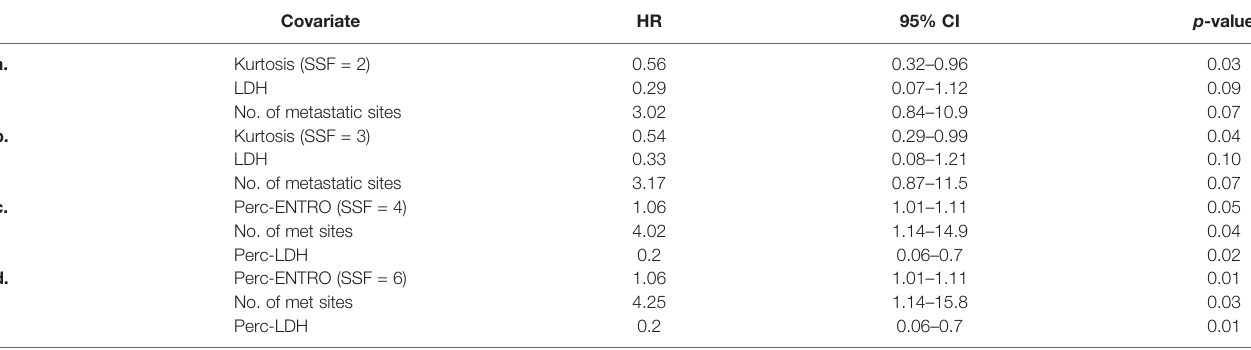
TABLE 2 | (a – d) Multivariate Cox regression analysis including individual signi fi cant univariate texture parameters (selected using LASSO) and clinical variables for predicting OS.